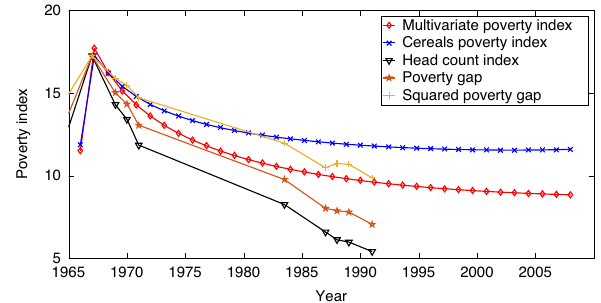
Fig. 7 Plots of multivariate poverty indices for the dimension reduced model. As expected, the curve behaves in a similar fashion to the cereals- only model of ref. 21 but also accounts for the increase in poverty observed around t = 1966 as seen in the alternative poverty index measures: the Head Count Index, Poverty Gap, and Squared Poverty Gap. These alternative measures have been scaled against the maximum of the index values. The model was constructed using data from 1959 – 1991 and veri fi ed against data in 2001 and 2005, each with more than 90%